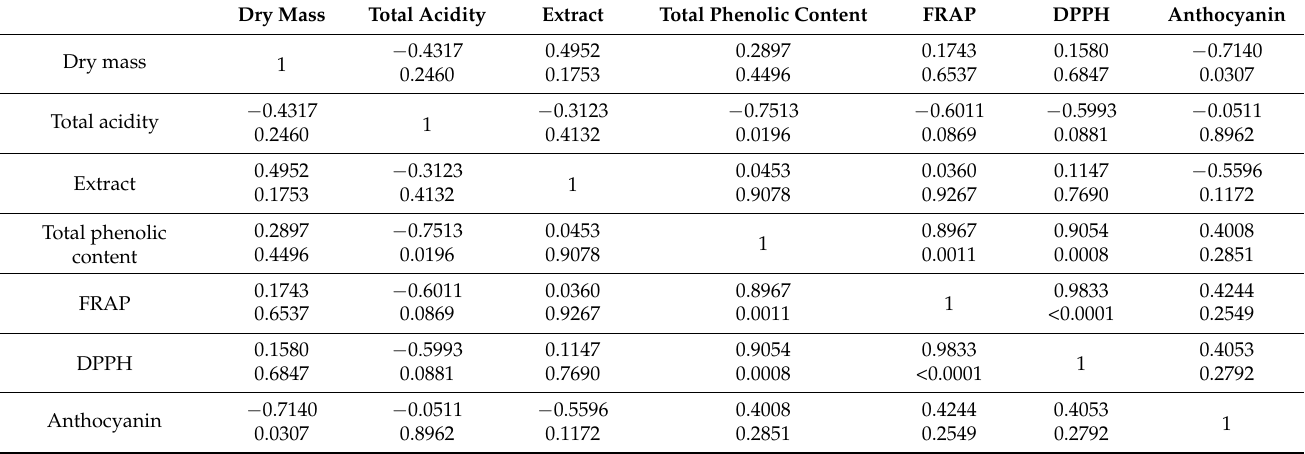
Table 4. Correlation coefficient for biologically active compounds in the ‘Einset Seedless’ fruits and their significance.